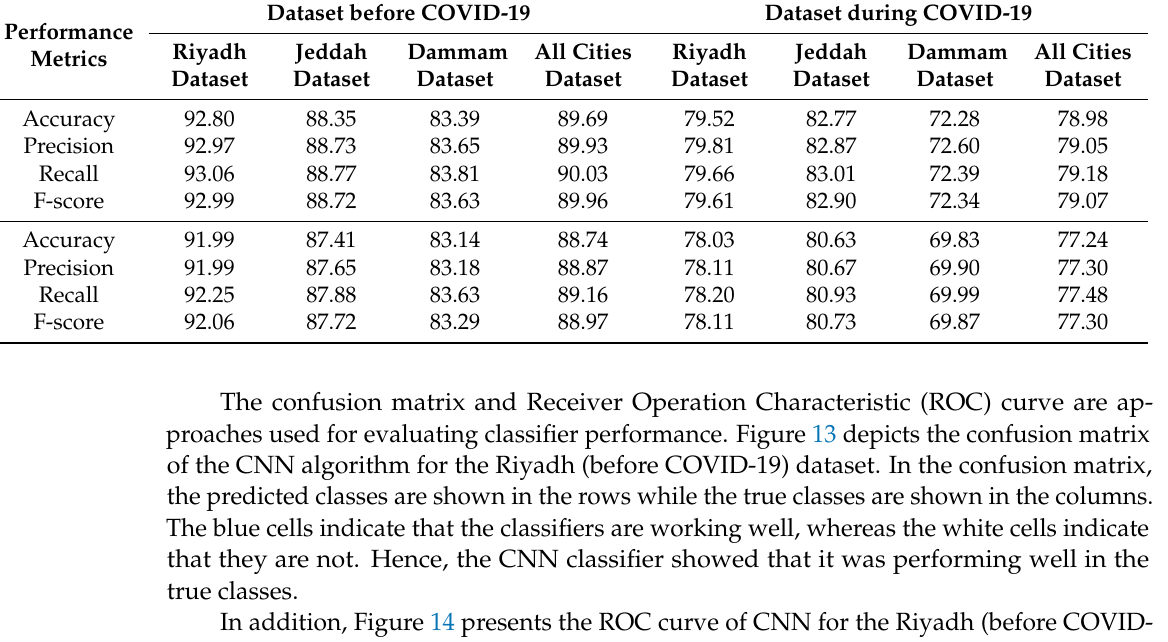
Figure 13. Confusion matrix of CNN algorithm for Riyadh dataset (before COVID-19) dataset.